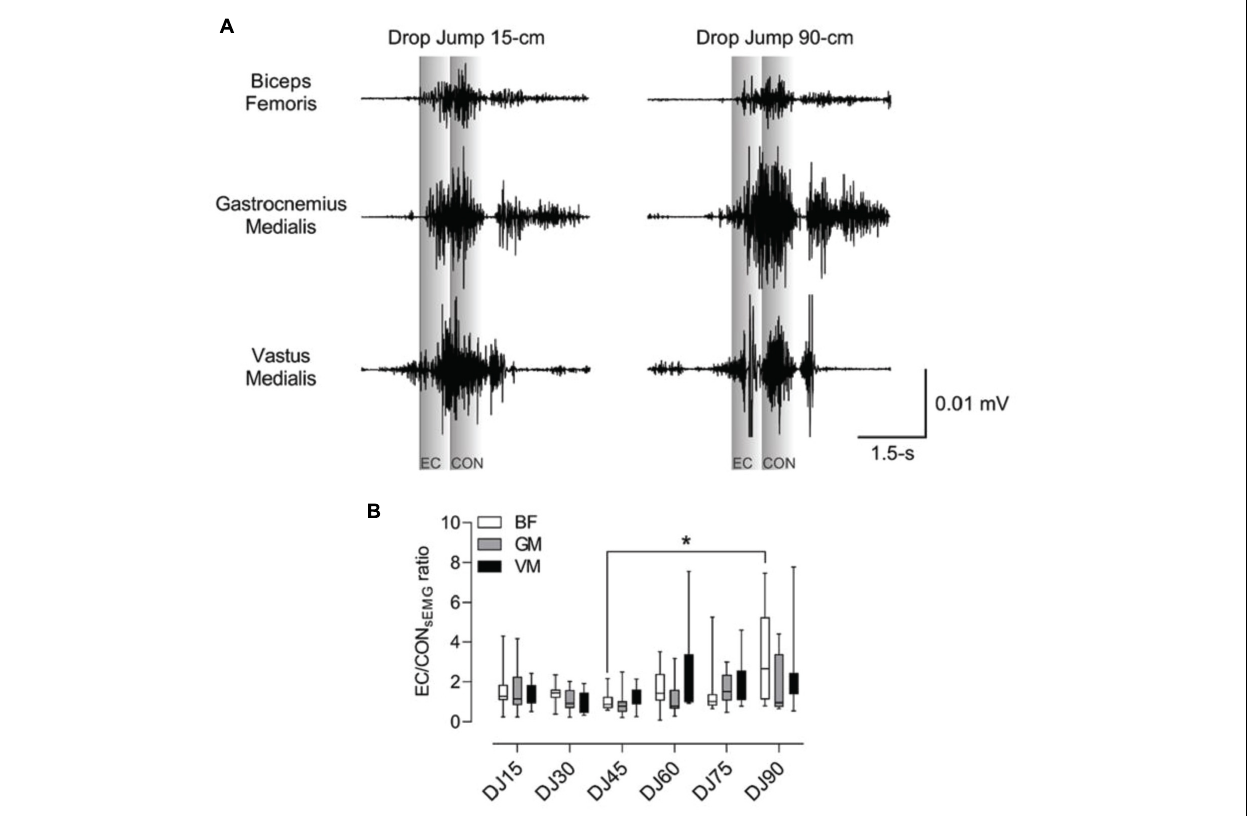
FIGURE 2 | Eccentric (EC) to concentric (CON) surface electromyography (sEMG) ratio in the biceps femoris (BF), gastrocnemius medialis (GM), and vastus medialis (VM) muscles of female volleyball athletes. (A) Representative sEMG recording from BF, GM, and VM of one athlete performing drop jumps from 15 cm (DJ15) and to 90 cm (DJ90). (B) Note that compared to the EC/CON sEMG BF ratio achieved after DJ45 (i.e., 1.0), a significantly ( p = 0.03) greater ratio was observed after DJ90 (i.e., 3.2). Data are showed as median and interquartile range, n = 10. *Significantly ( p = 0.03) greater after DJ90 compared to